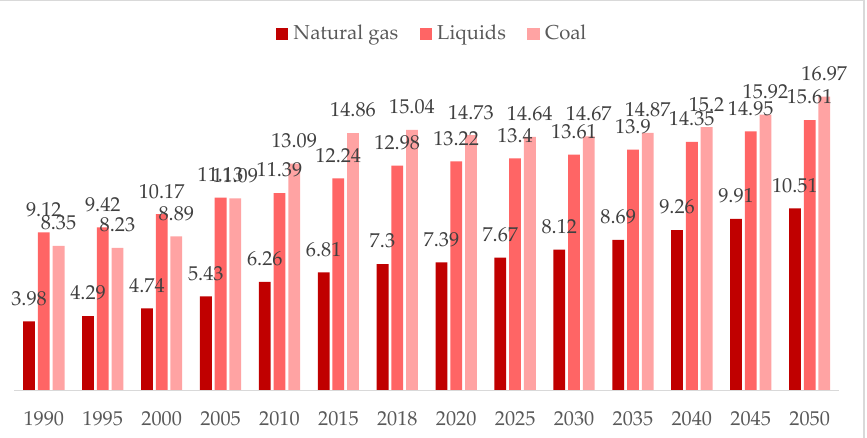
Figure 5. Energy ‐ related carbon dioxide emissions worldwide from 1990 to 2050 (where the forecast data are from 2020) by fuel, in billion metric tons [26].